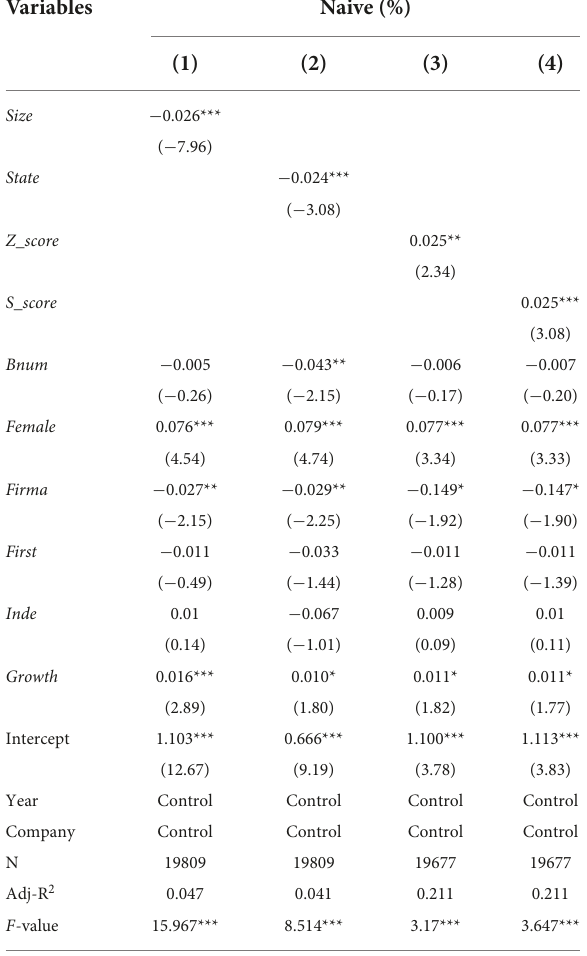
TABLE 11 Regression analysis of the presence of naive